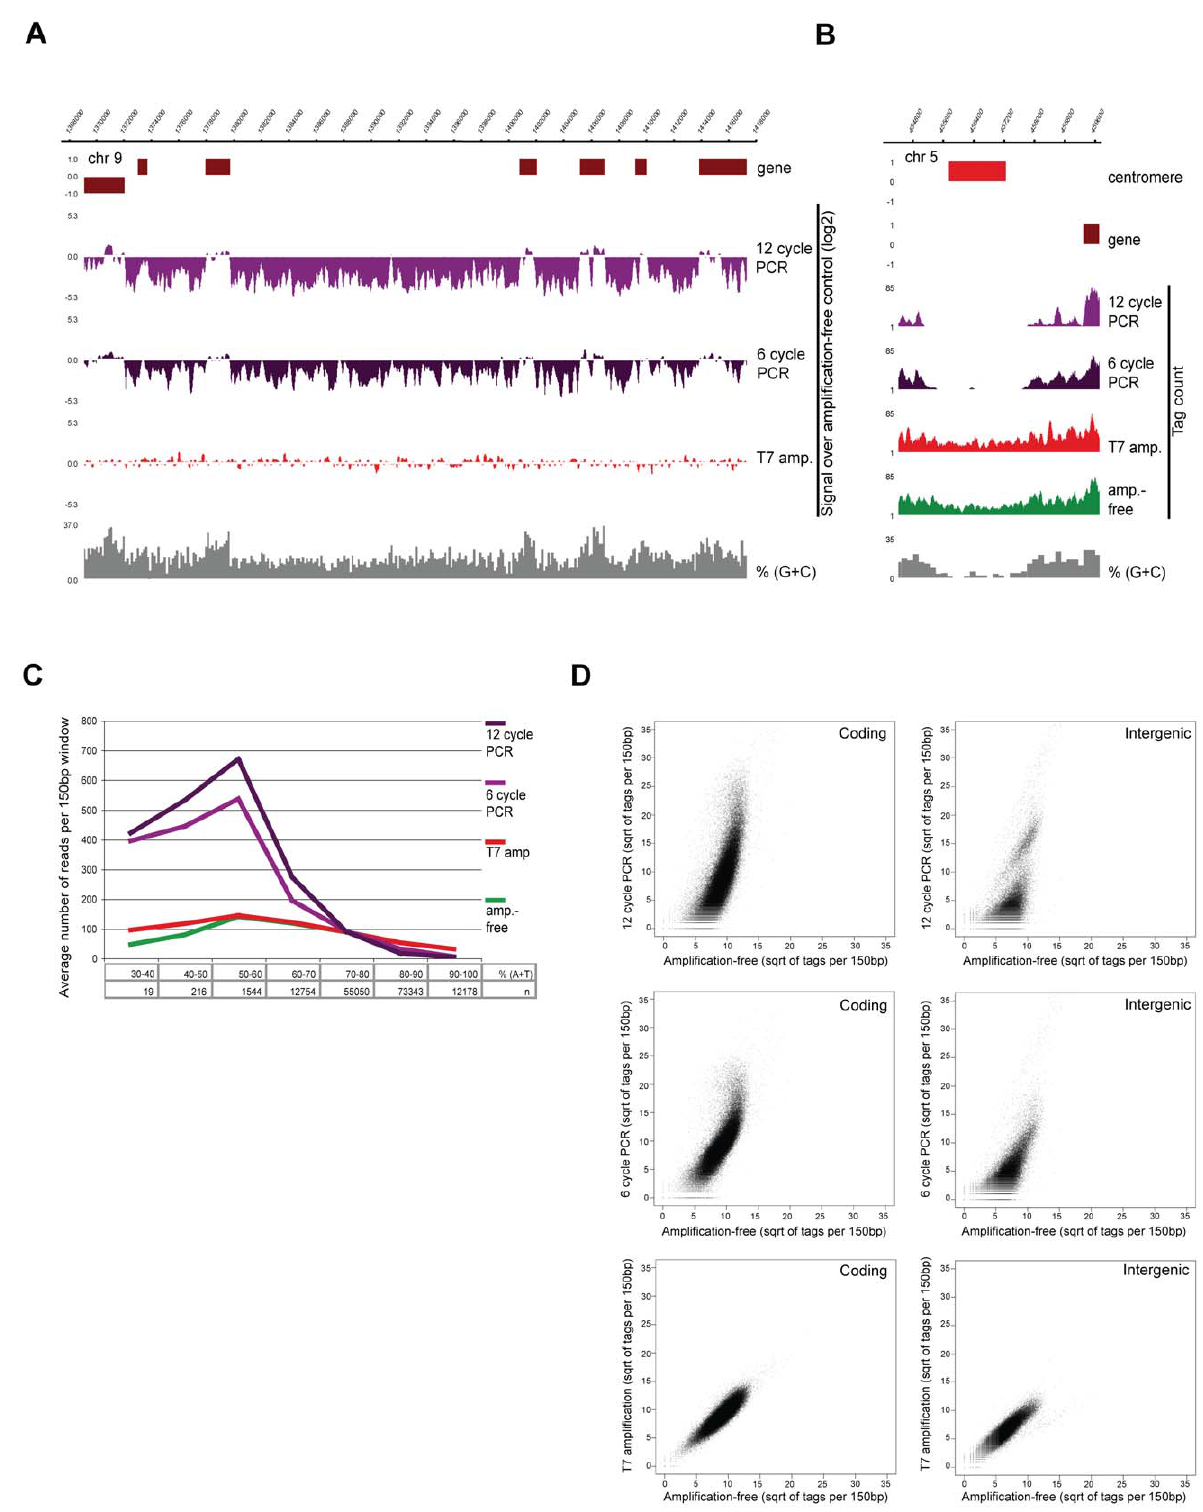
Figure 1. T7 amplification results in perfectly representative libraries for Illumina sequencing. ( A–B ) Screenshots of sequencing data of P. falciparum genomic DNA prepared by different amplification methods on ( A ) a part of chr9 (log2-ratio plots of the sequencing data obtained after amplification over amplification-free control) and ( B ) the centromeric regions of chr5 (76 bp sequence reads plotted per 10 bp window) ( C ) distribution of sequence reads in relation to AT-content (‘‘n’’ refers to the number of 150 bp windows with given AT-content, y-axis displays average number of tags per 150 bp window) ( D ) Scatterplot analysis of amplified sequencing data against amplification-free gold standard in 150 bp windows across GC-richer coding and AT-rich intergenic regions of the P. falciparum genome.